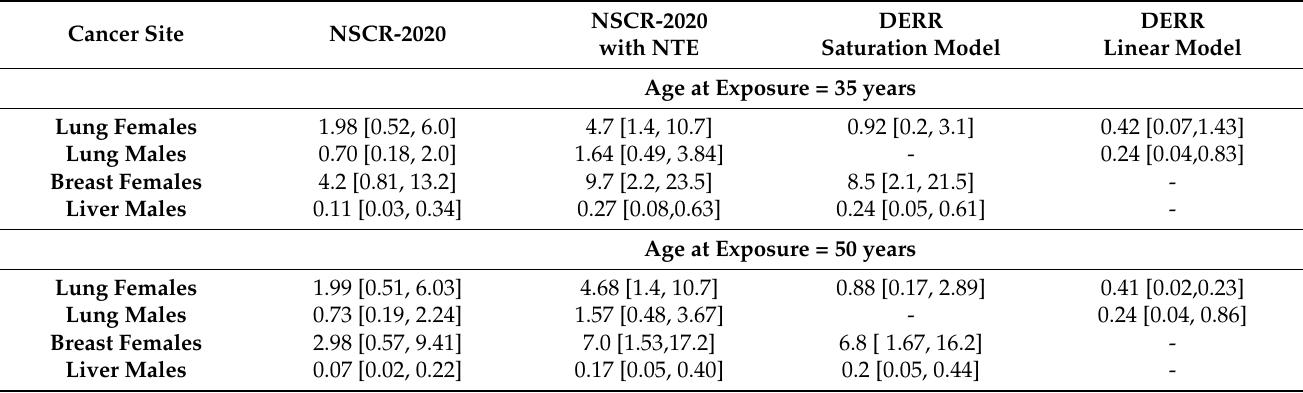
Table 5. Predictions of risk of exposure-induced cancer (REIC) for 1-year exposures with average solar minimum conditions for astronauts of 35 and 50 y at mission launch. Results for the NSCR-2020 model with and without non-target effects (NTE) are shown in comparison to the DERR model. Uncertainties for physics and the κ and m parameters are the same in each prediction as described previously [9,20]. Uncertainties in other parameters are distinct for the various predictive